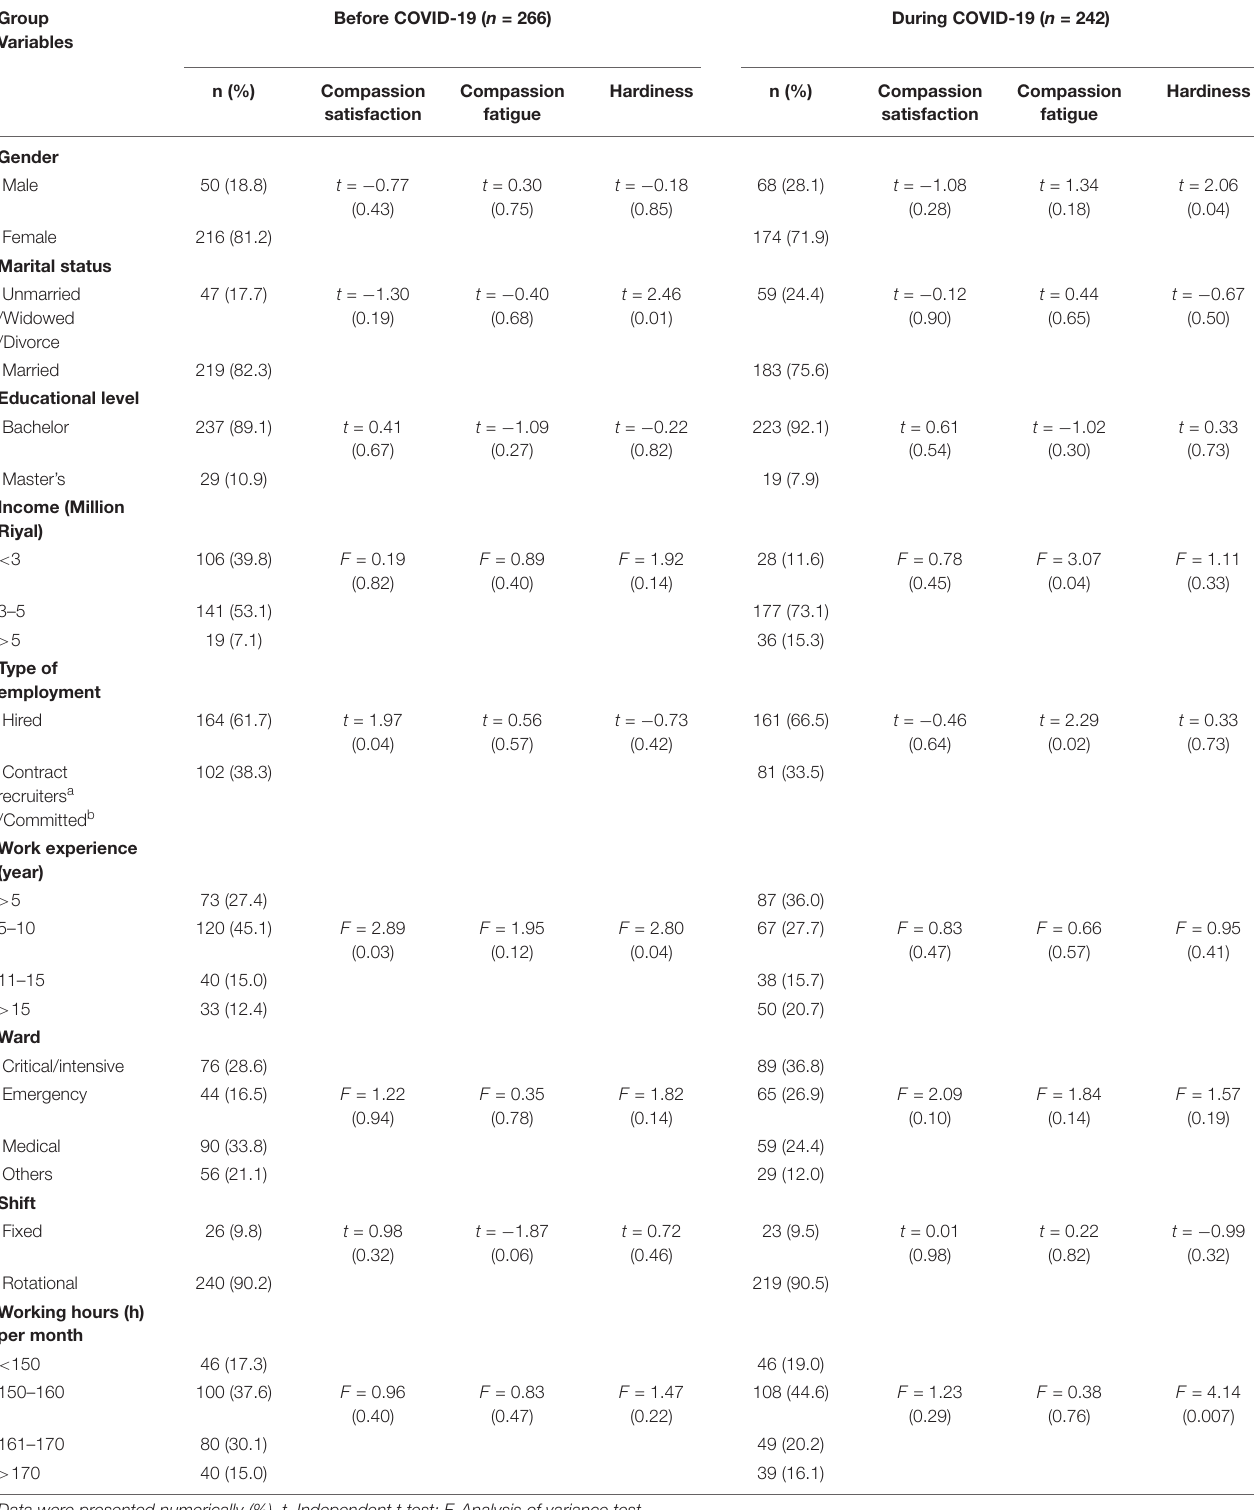
TABLE 1 | Comparison of the demographic characteristics of the participants before the COVID-19 and during the COVID-19. Group Variables